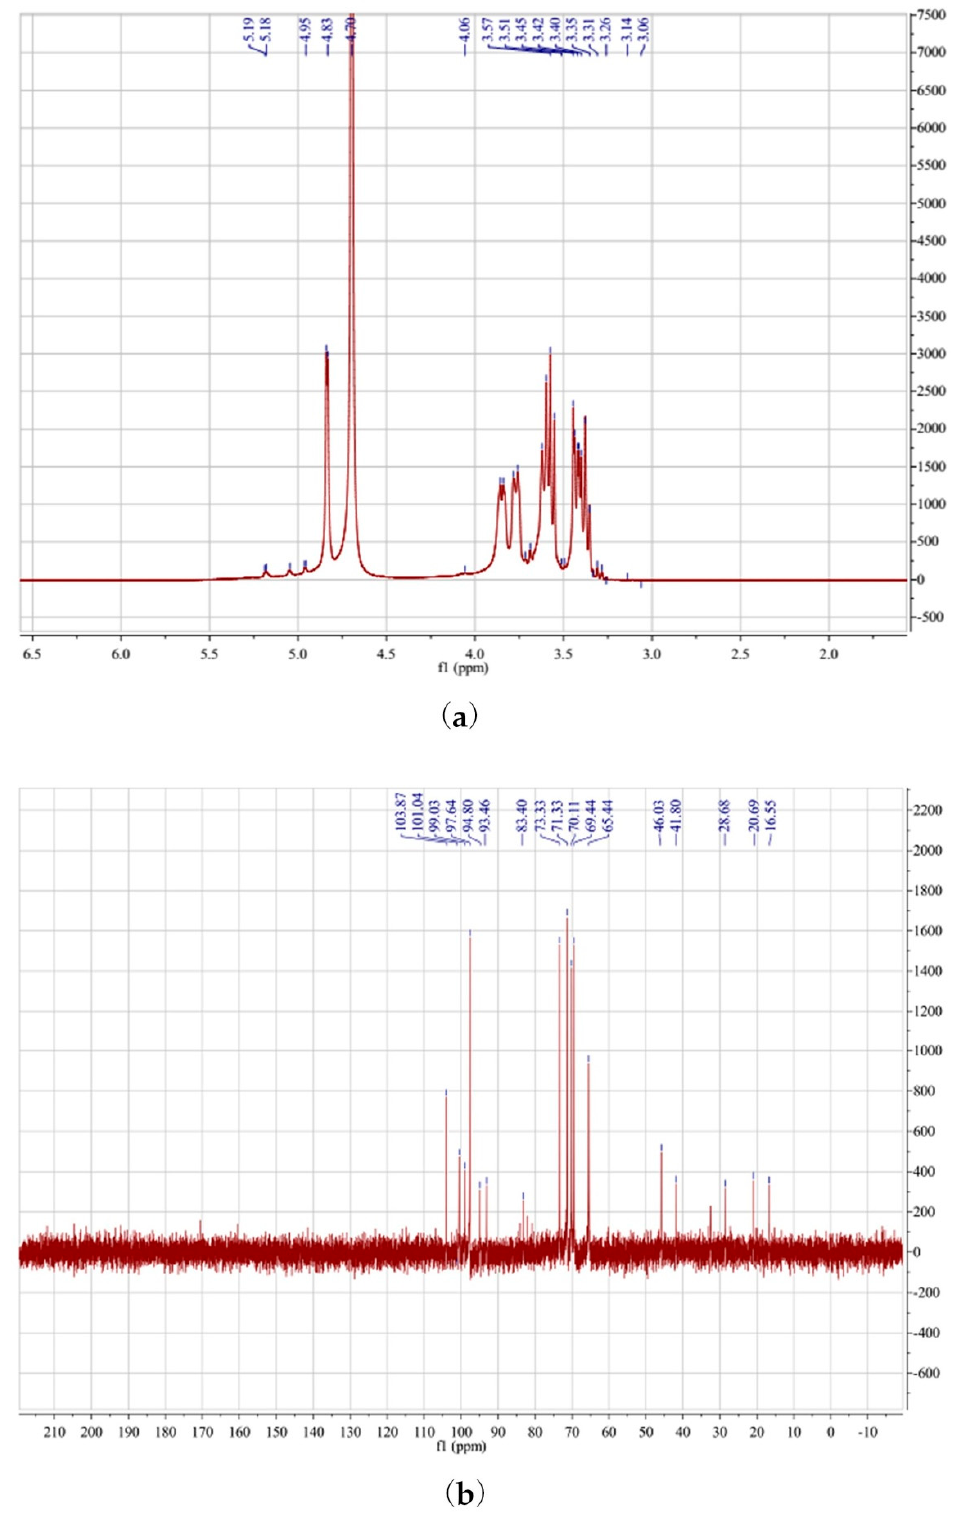
Figure 7. 1 H NMR spectrum ( a ) and 13 C NMR spectrum ( b ) of P-IIa.